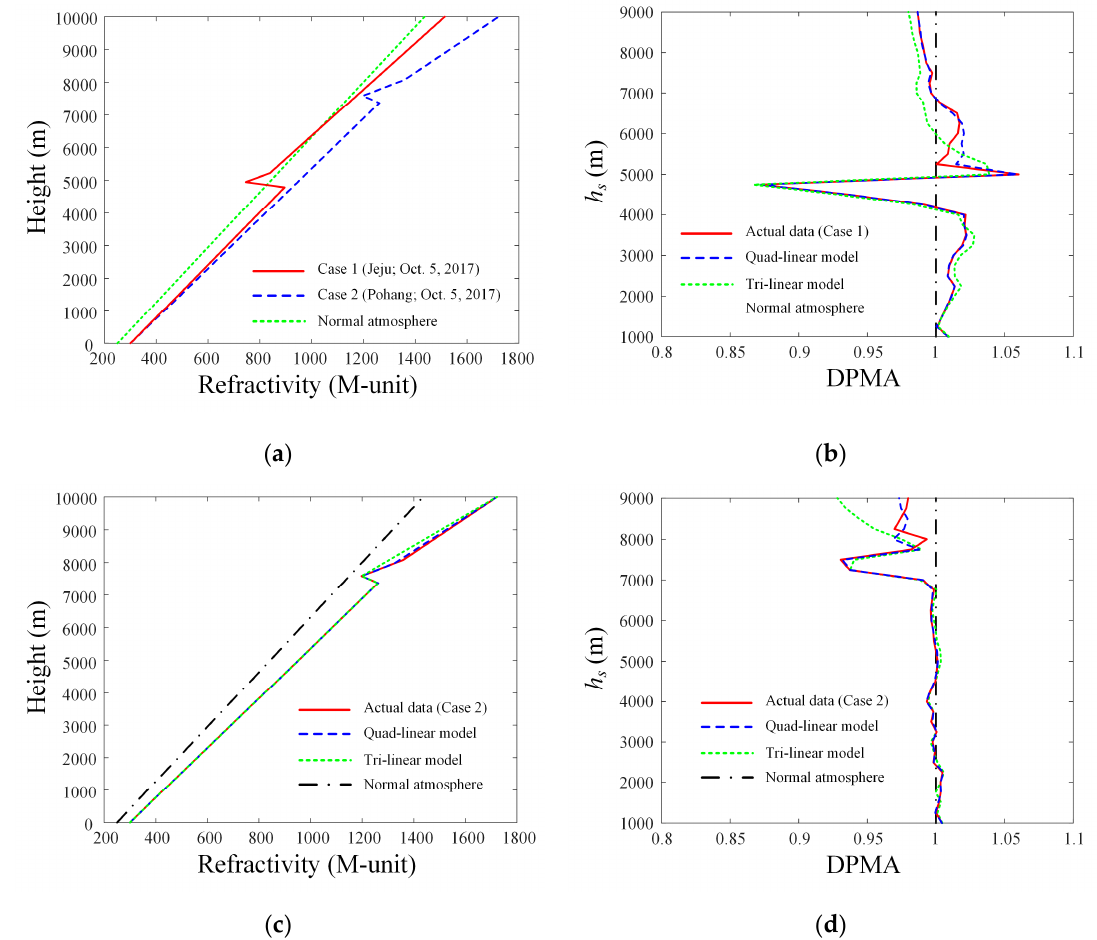
Figure 10. Two actual abnormal cases in the DPMA map with tri- and quad-linear modeling: ( a ) refractivity of Case 1; ( b ) DPMA according to h s for Case 1; ( c ) refractivity of Case 2; ( d ) DPMA according to h s for Case 2.